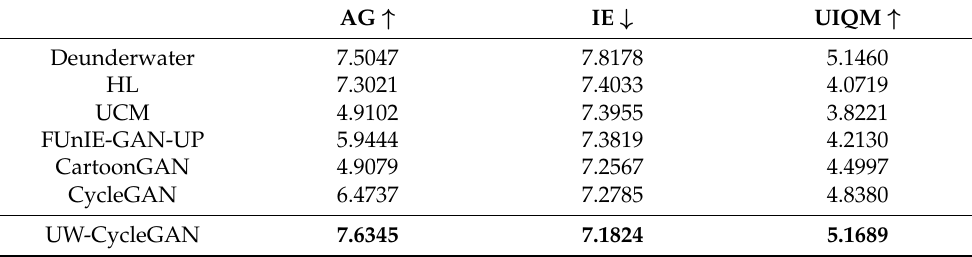
Table 1. Quality evaluation of all methods on the URPC dataset.